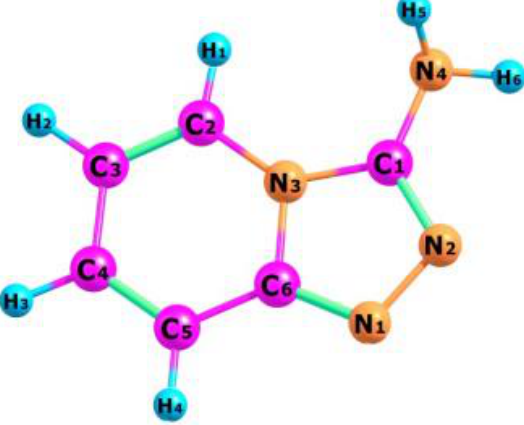
Figure 4. Molecular structure of TPa-NH 2 with numbering atoms.